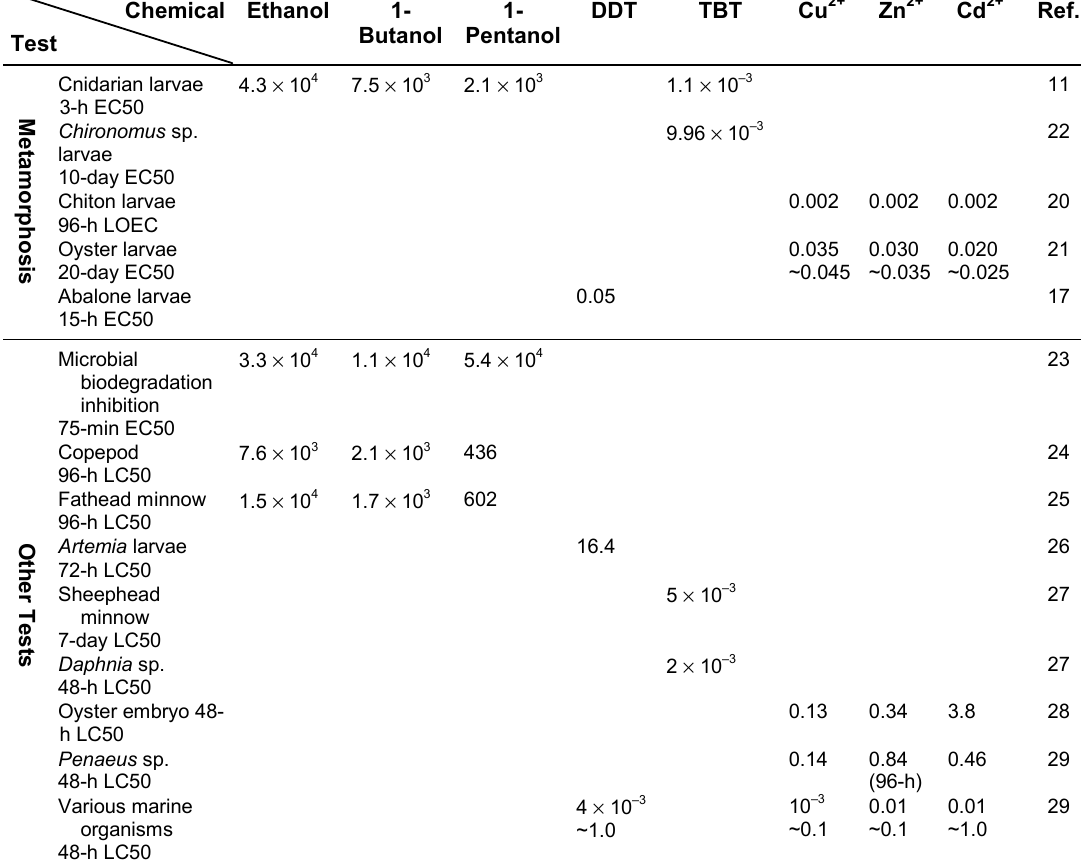
Toxicity of Some Chemicals (mg/dm 3 ) to Various Aquatic